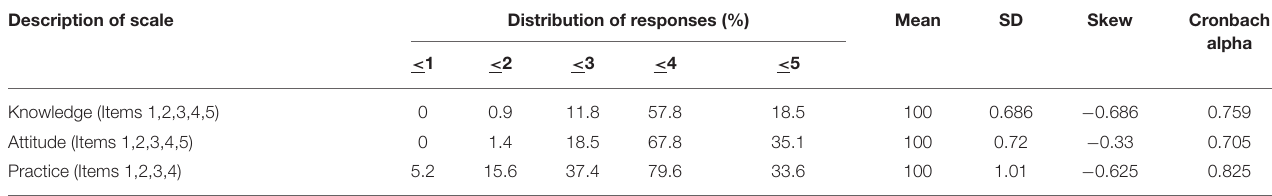
TABLE 5 | Distribution and internal consistency of knowledge, attitude, and practice of community pharmacists’ toward non-pharmaceutical products. Description of